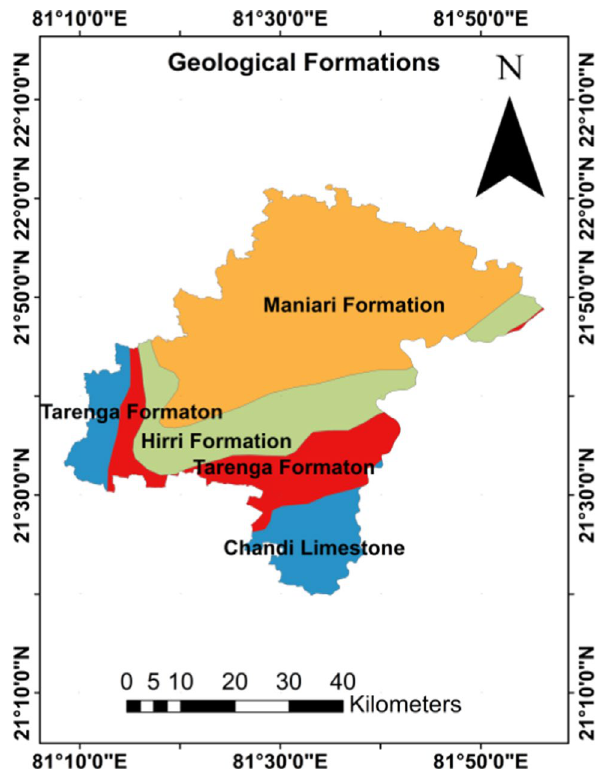
Fig. 2 Geology map of the study